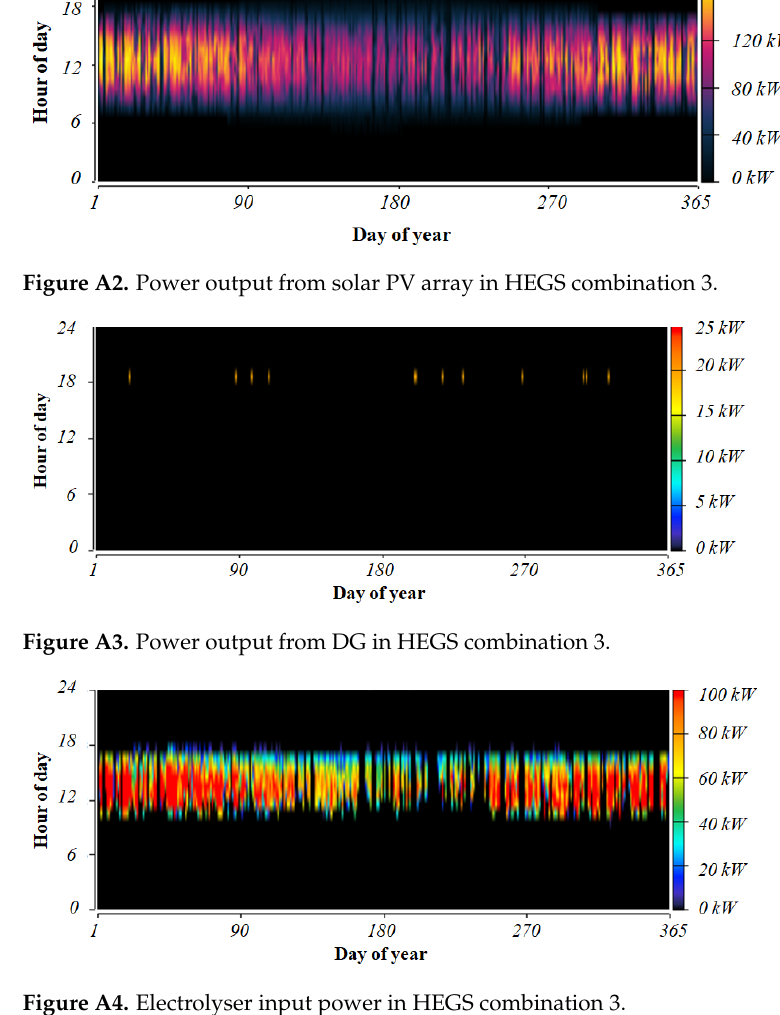
Figure A5. Hydrogen output from reformer in HEGS combination 3. Figure A6. Hydrogen tank level in HEGS combination 3. References 1.